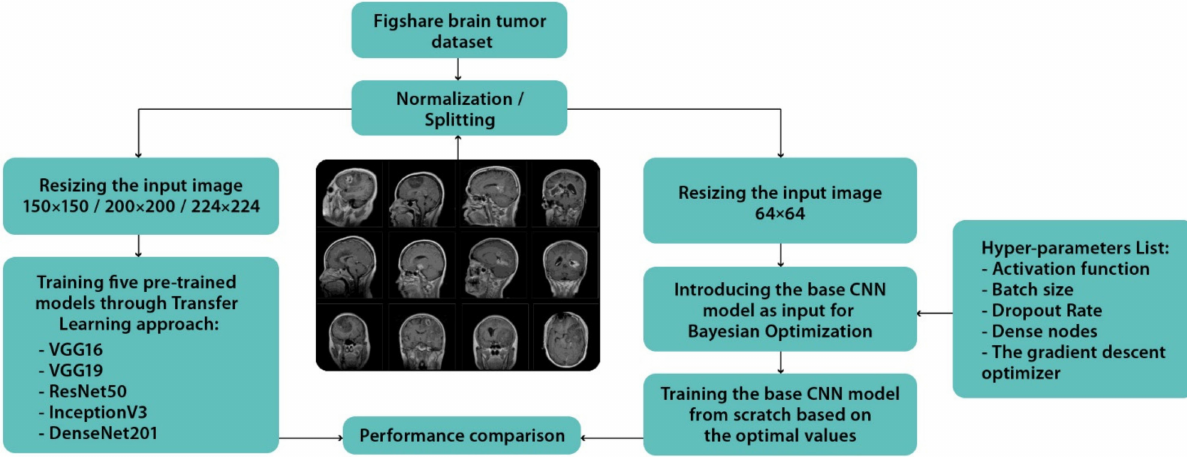
Figure 3. The proposed